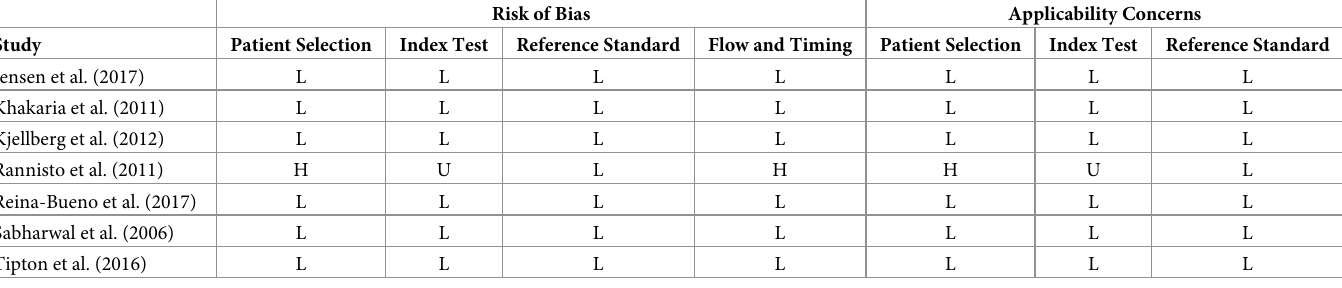
Table 2. QUADAS 2- tool for the evaluation of quality of the included validity studies on imaging diagnostics for the measurement of leg length discrepancy (n =